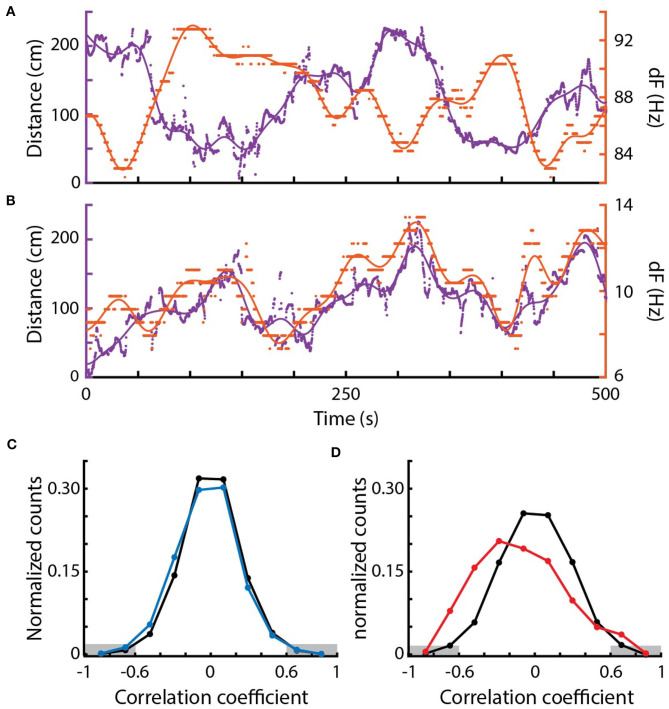
Correlations between EOD frequency and movement. (A) Example of a strong negative correlation between distance (purple, left) and dF (orange, right) of a pair of Eigenmannia over a period of 500 s. Dots are measurements, lines are low-pass fits of the data. (B) Example of a strong positive correlation. (C) Distribution of Pearson correlations between distance and dF for surface fish (blue) and shuffled data (black). (D) Distribution of Pearson correlations between distance and dF for cavefish (red) and shuffled data (black). There were significantly more strong Pearson correlations, below −0.6 and above 0.6 (marked in gray) in the original data when compared to the shuffled data in cavefish but not surface fish.